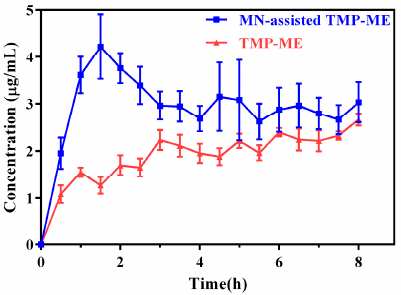
Figure 4. TMP levels in rat skin dialysate in vivo for TMP-ME and MN-assisted TMP-ME ( n = 5).